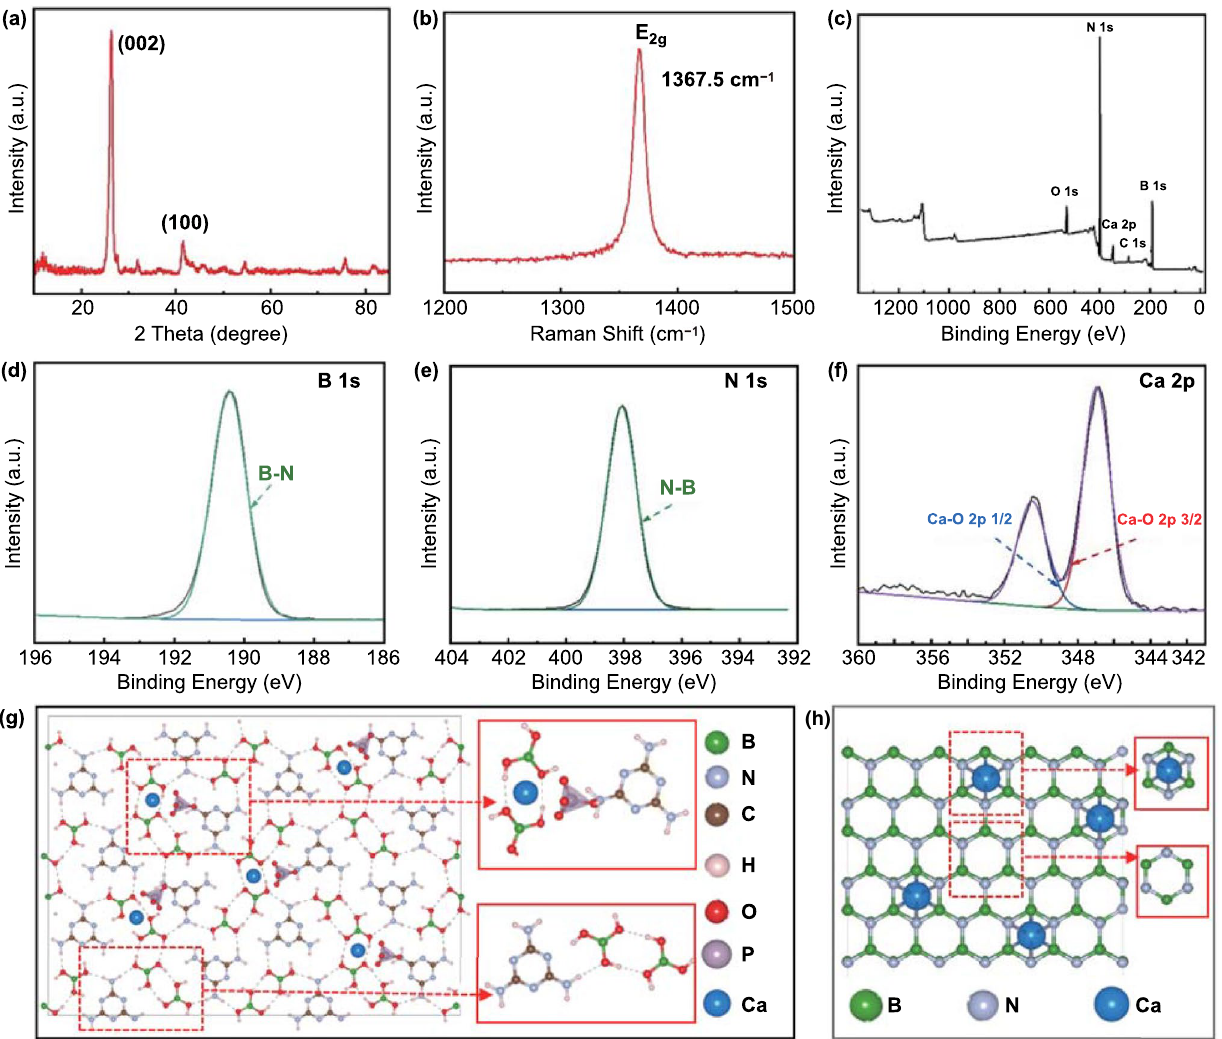
Fig. 2 a XRD pattern of Ca-BN aerogel. b Raman spectrum of Ca-BN aerogel. c XPS survey of Ca-BN aerogel. d – f B 1s, N 1s, Ca 2p spectra of Ca-BN aerogel. g Schematic plots of Ca 3 (PO 4 ) 2 molecule adsorbed on M·2B. h Schematic plots of Ca atom in Ca-BN, the insets illustrate the detailed